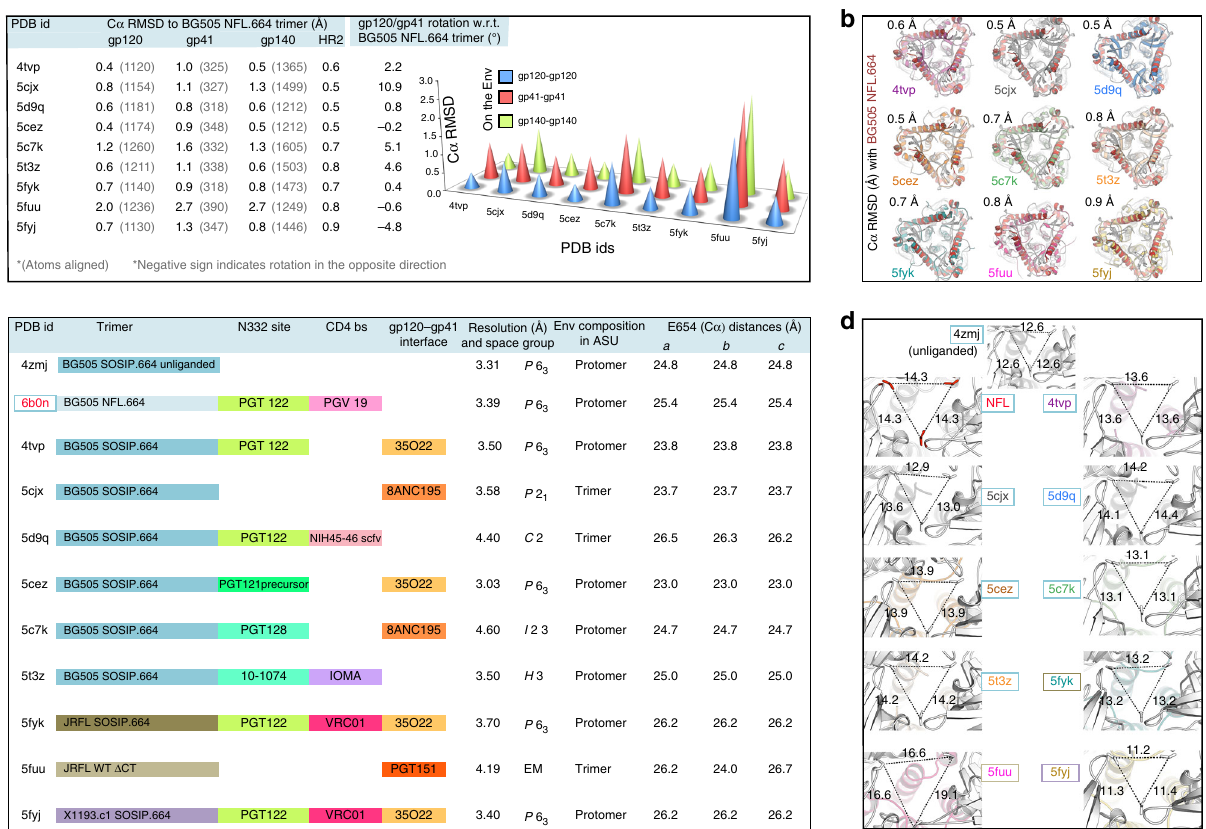
Fig. 4 Inherent fl exibility and effect of the binding of antibodies on trimer opening. a Inter-domain fl exibility observed by aligning the trimeric gp120 and gp41 individually on the Env spike for available HIV trimer structures, in contrast to the overall C α RMSDs (Å) of the trimeric gp140s also illustrated on the right. b Contribution of HR2 to the movement observed at the base of the HIV Env constructs measured in C α RMSD (Å) as in a . Rotation (°) between the gp120/gp41 domains measured on the soluble Env with respect to BG505 NFL.664. To calculate subdomain rotation, the angle between gp120/gp41 was measured using three points on the Env, namely, C α atoms of the conserved W571 and Q591 on HR2 and a pseudoatom placed at the center of mass (https://pymolwiki.org/index.php/Center_of_mass) of gp120. This value was then subtracted from the angle measured for BG505 NFL.664 to infer rotation between the subdomains. c A list of the available Env trimer structures with a description of the epitope(s) occupied, resolution (Å), space group, Env component in the asymmetric unit (ASU), and the distances between E654 on each protomer marking the coordinates at the Env base as sides of the triangle a , b and c . d Inter-V2 distances (Å) measured between R166 (C α ) on each gp41 at the trimer apex for available HIV trimer structures of various isolates and designs in